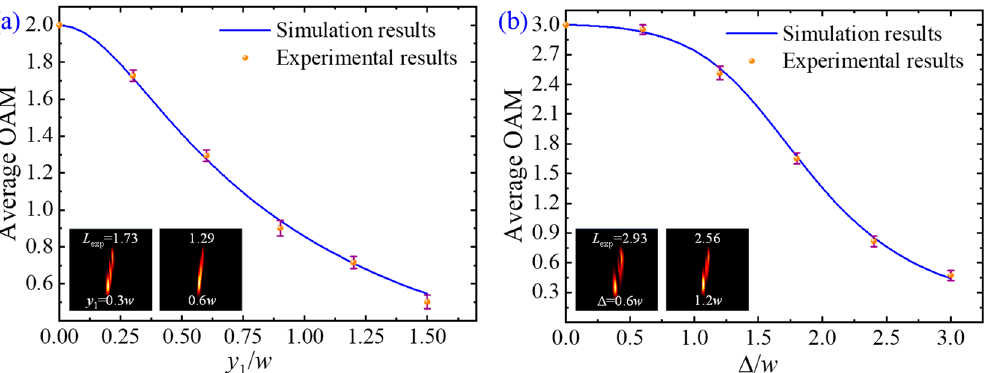
Figure 9. The average OAM values of ( a ) off-axis single vortex beams with different values of y 1 when m = 2 and x 1 = 0, and ( b ) off-axis double vortex beams with different values of Δ when m 1 = 1, m 2 = 2, and x 1 = x 2 = 0. The scatters are the experimental data, while the solid lines are the numerical simulations by Equation (23). The inserts are exemplary intensity distributions at the focal plane of the cylindrical lens.